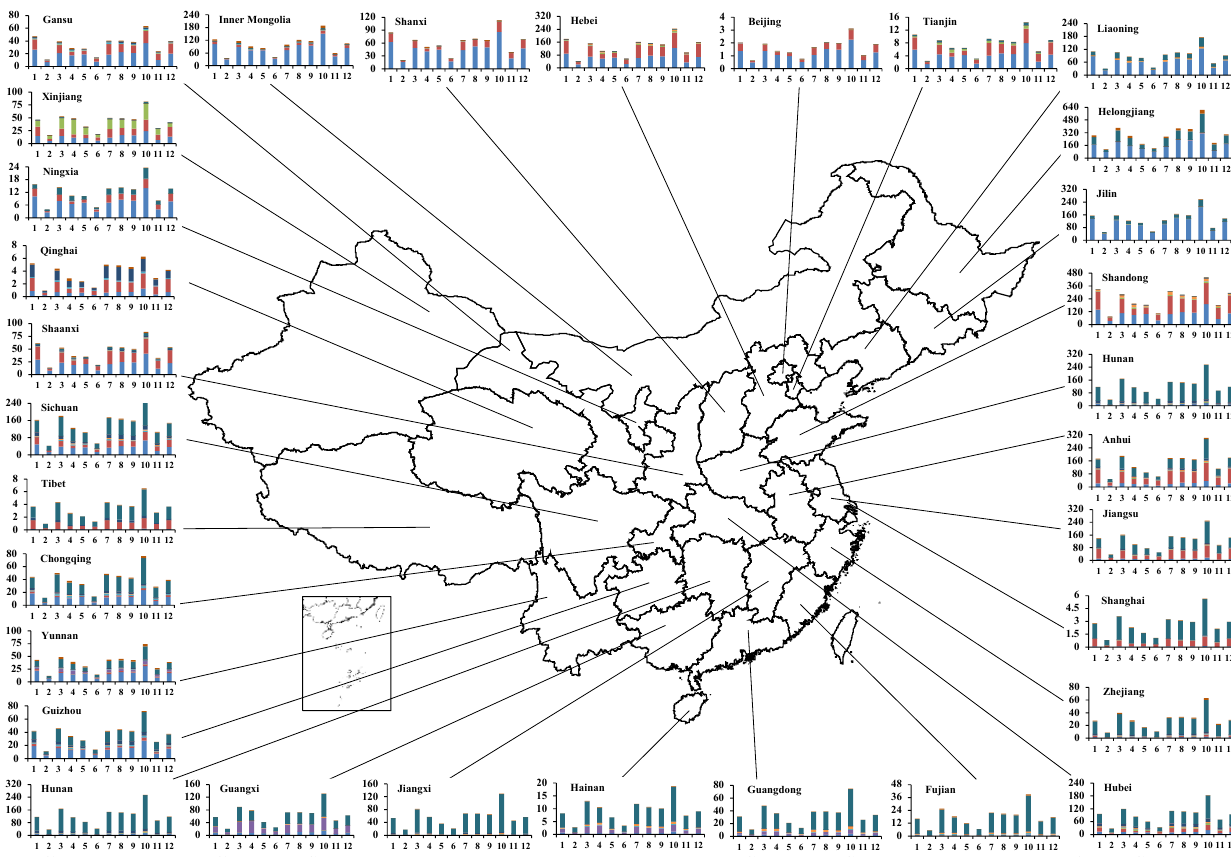
Figure 5. Contributions of different crop straw types to the emission in each province (Gg). Note that numbers 1–12 represent the pollutants of SO 2 × 10, NO x , NMVOC, NH 3 × 10, EC × 10, OC, CO / 10, PM 10 , PM 2 . 5 , CO 2 / 100, CH 4 , and Hg × 1000000,